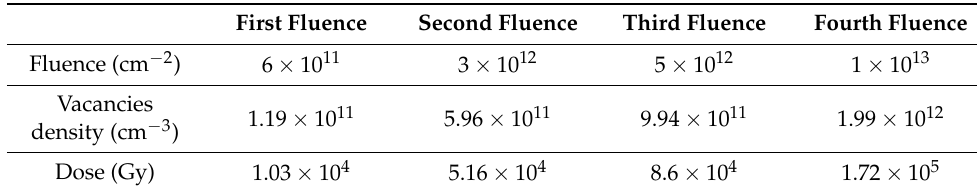
Table 2. Fluences used to irradiate the sensor inside the membrane and on the bulk, with a 3.5 MeV proton beam (transmission beam). Four fluences were chosen, and the highest one was used just on the membrane. Respective vacancies’ densities and the doses are also reported.